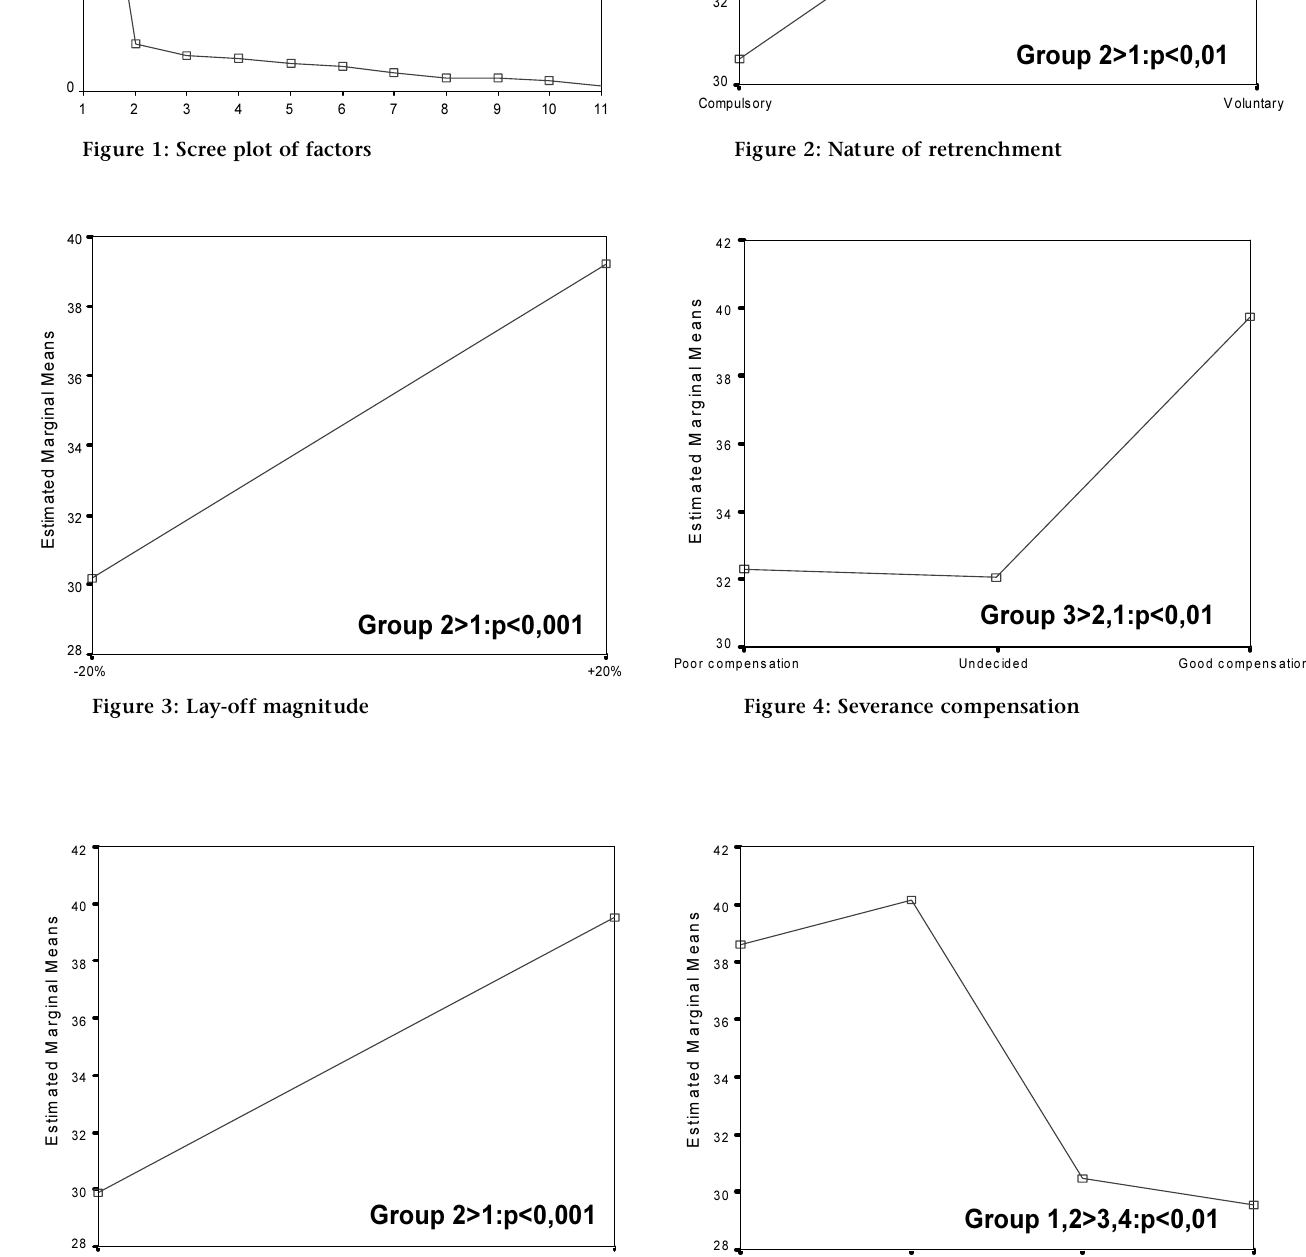
Group 2>1:p<0,01